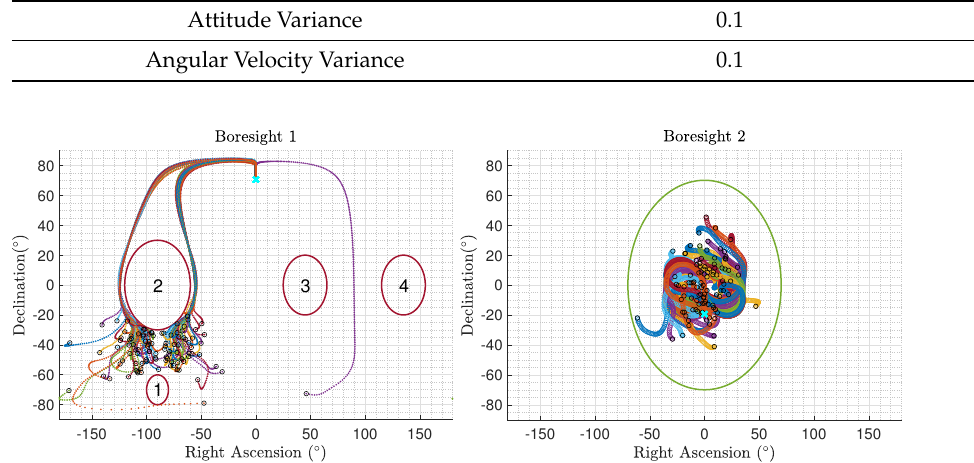
Figure 14. Monte Carlo results for sensitive equipment placed in the x-body axis with respect to the exclusion constraints ( Boresight 1 ) and for equipment placed in the y-body axis with respect to the inclusion constraints ( Boresight 2